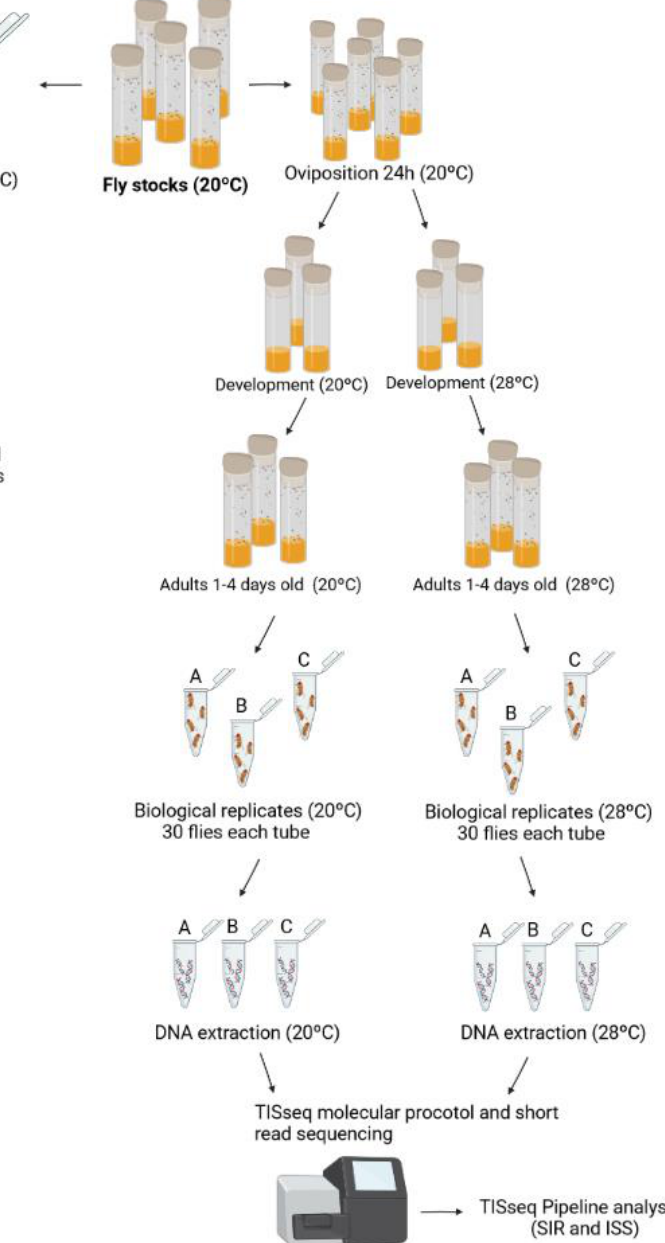
Figure 2. Biological treatments and experiment design. The fly stocks were maintained at 20 °C and the flies were used for DNA extraction and whole-genome sequencing, using long-read sequencing, and for treatment of temperature and short-read sequencing. First, 20 flies maintained at 20 °C were used for DNA extraction, and later, sequencing was performed. Second, mated flies (20 °C) were used for oviposition for 24 h at 20 °C. After that, half of the bottles were kept at 20 °C and the other half at 28 °C during the development. Flies that were born within 4 days (1 – 4 days) were collected and DNA was extracted, with three biological replicates at each temperature. The molecular protocol for the TISseq experiment was performed and short-read-sequenced. This figure was generated at BioRender.com.